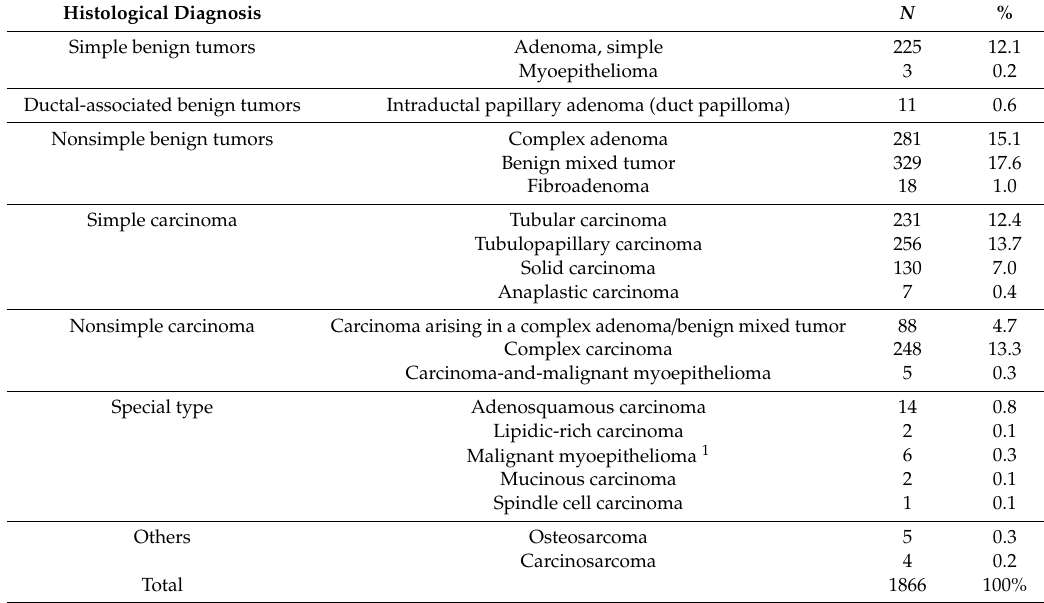
Table 2. Histological